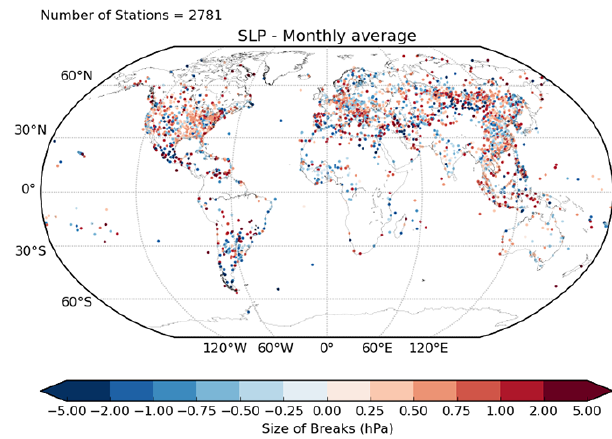
Figure 13. As for Fig. 6 (a) but for Fig. 13. As for Fig. 6(a) but for SLP.